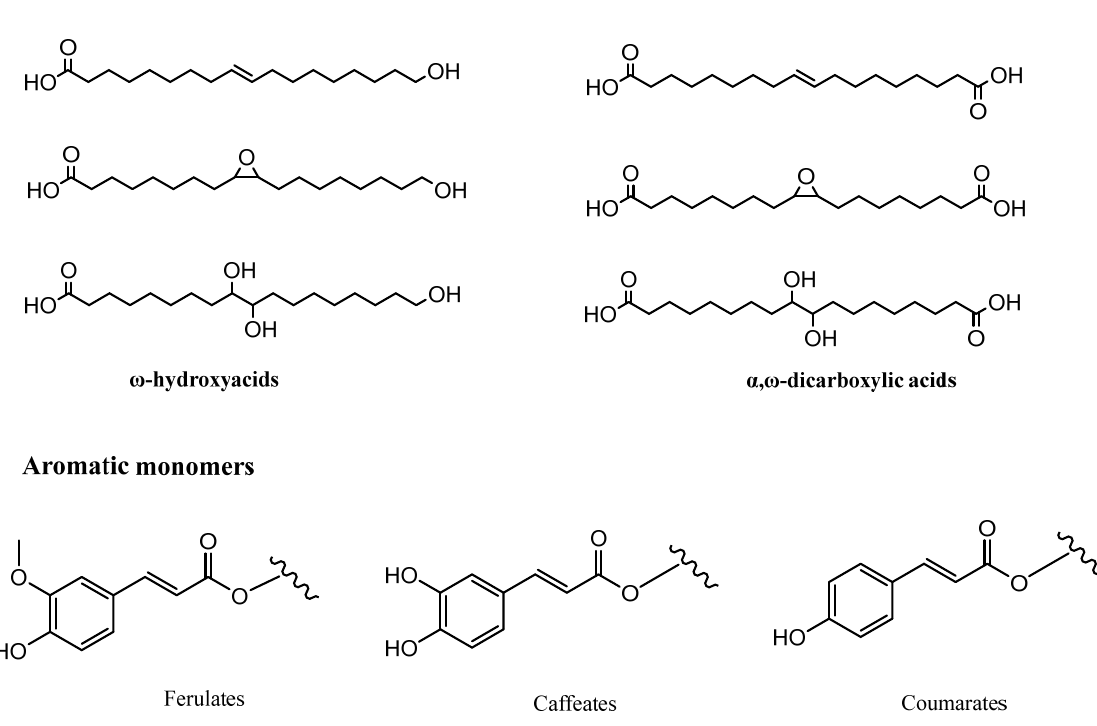
Figure 1. Structural formula of common monomers in suberin composition.